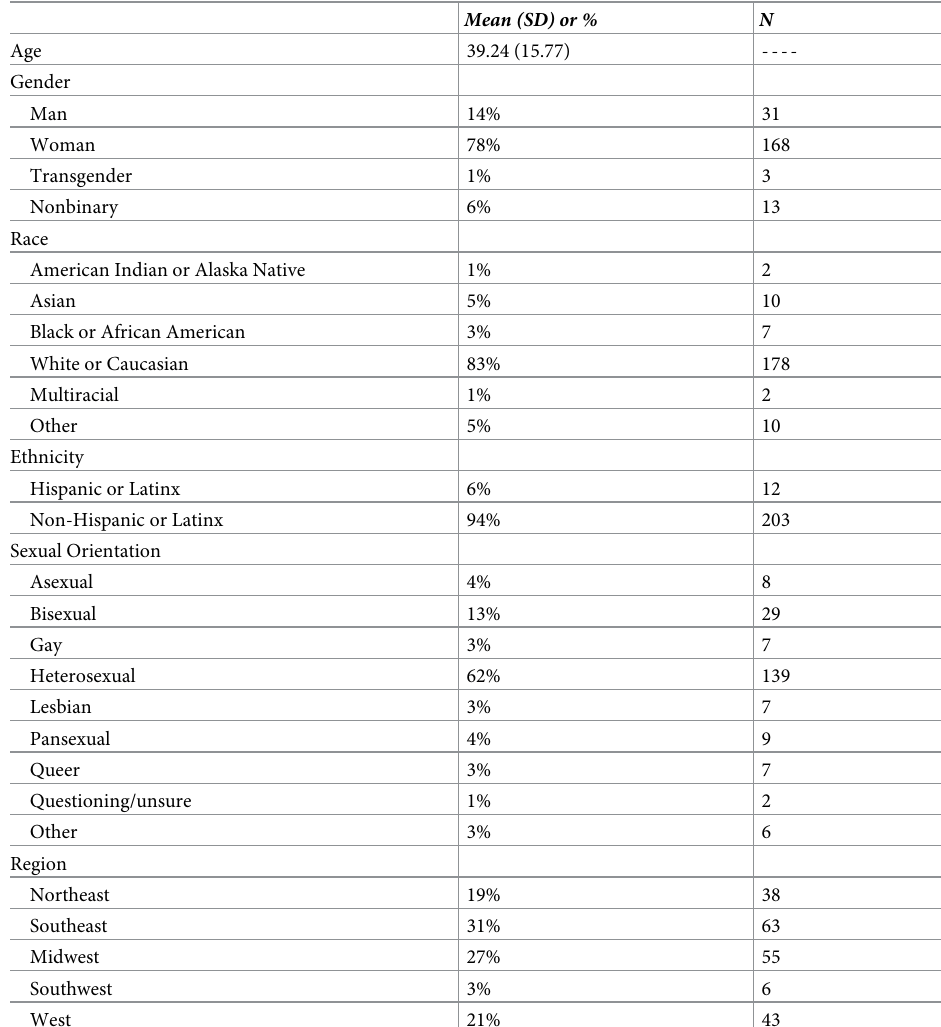
Table 1. Sample characteristics ( n =